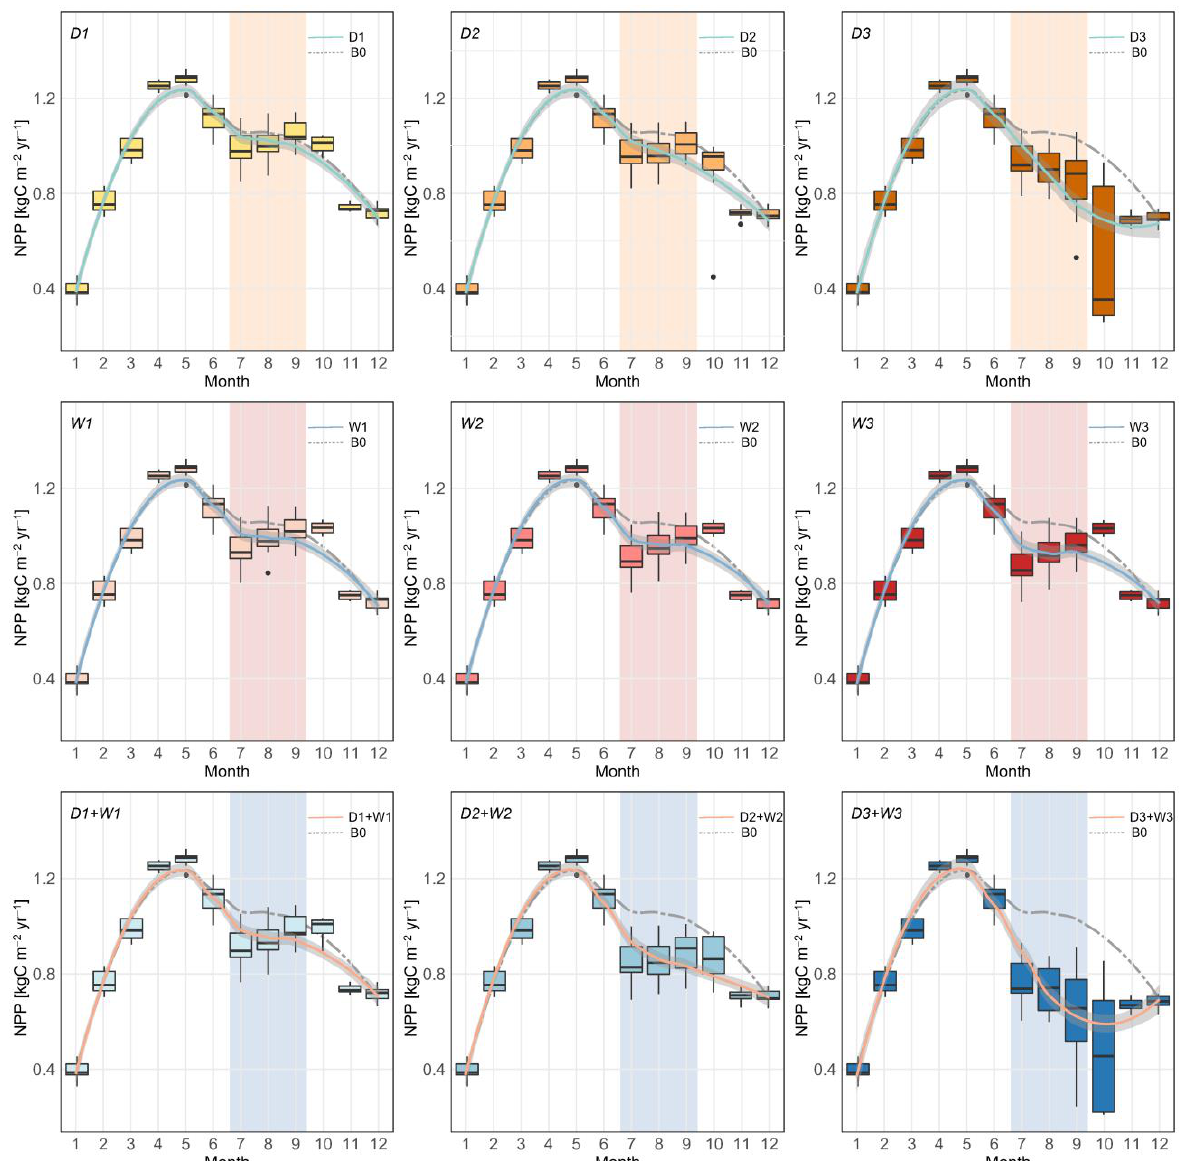
Figure 3. The average monthly simulated NPP [kgC m − 2 yr − 1 ] for 10 plots. The solid line represents the asymptote of NPP change, and the shadow it casts is the confidence interval. The month when the drought and/or warming scenarios occur is indicated by the shadow in the background. Black points indicate outliers.